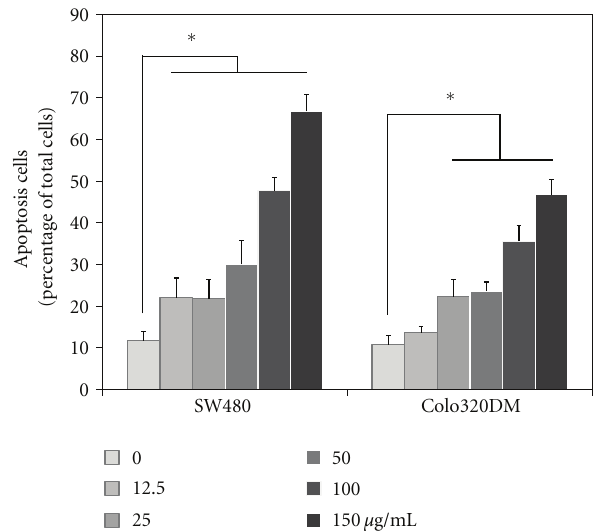
Figure 4: Detection of apoptotic induction by LCSP. Cells were treated with increasing concentrations ofLCSP as indicated, then incubated at 37 ◦ C for 24 h. The treated cells were then suspended and stained with annexin V conjugated with FITC. Ten thousand cells were analyzed by flow cytometry. Data are the averages of three independent experiments and are expressed as the mean ± SD. ∗ Represents a significant di ff erence ( P < 0 .